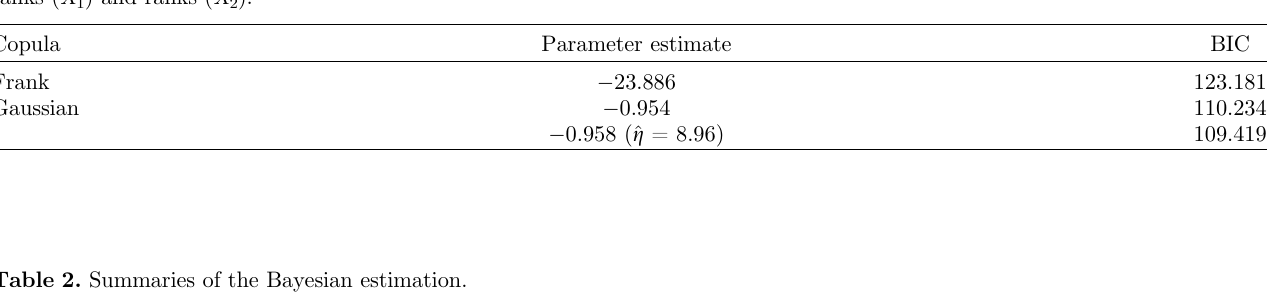
Table 2. Summaries of the Bayesian estimation.